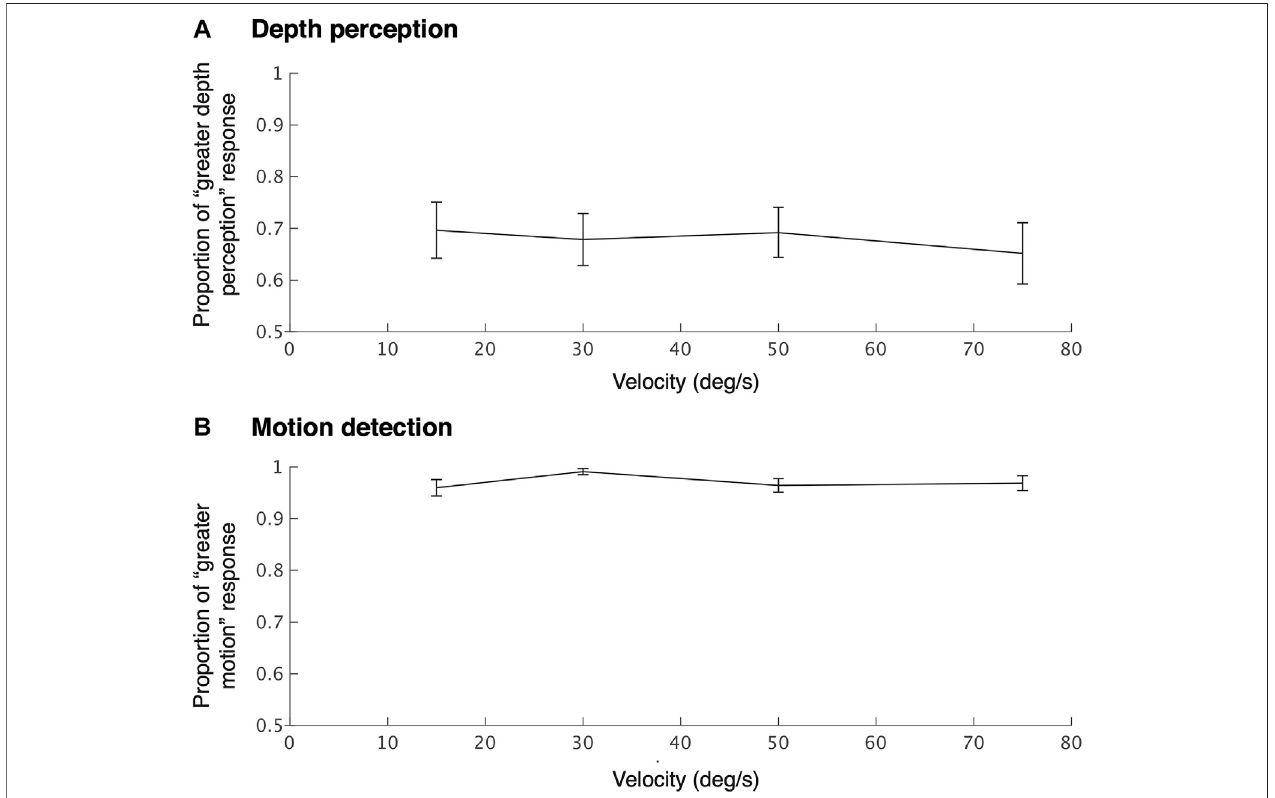
FIGURE14| Meanratioofhigherdepthperception (A) andmoremotiondetection (B) thanthecontrolcondition(stillimage)duringyawrotationtoupdateastereo image with the correct IPD in experiment 3.